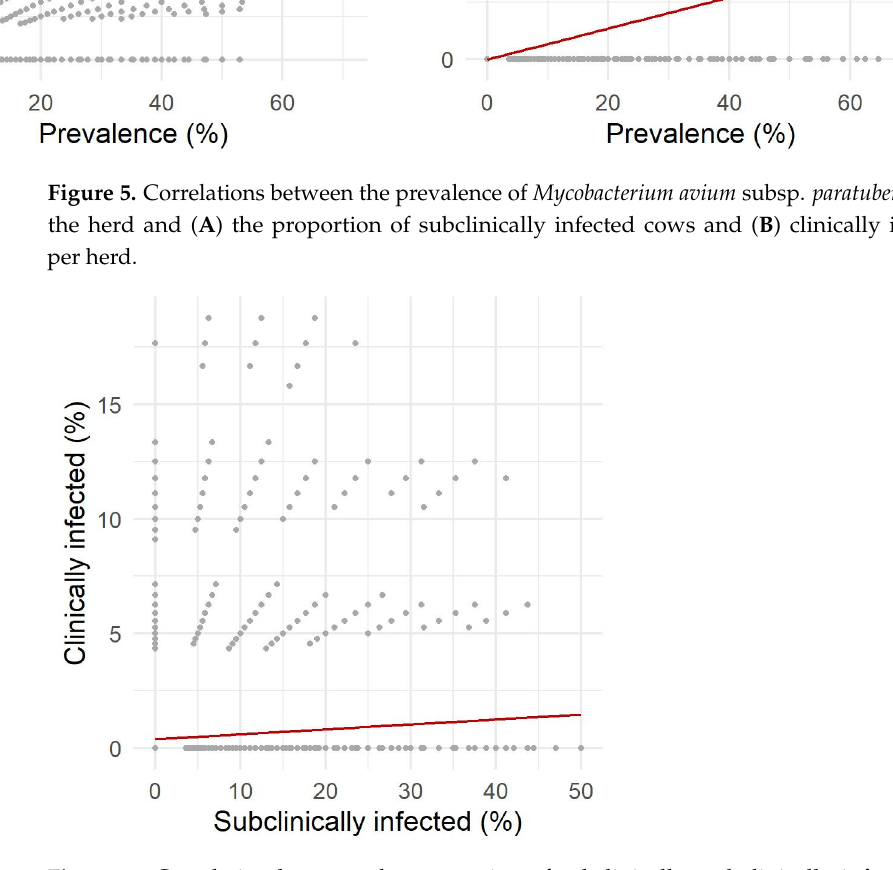
Figure 6. Correlation between the proportion of subclinically and clinically infected cows in a Mycobacterium avium subsp. Paratuberculosis -positive herd.